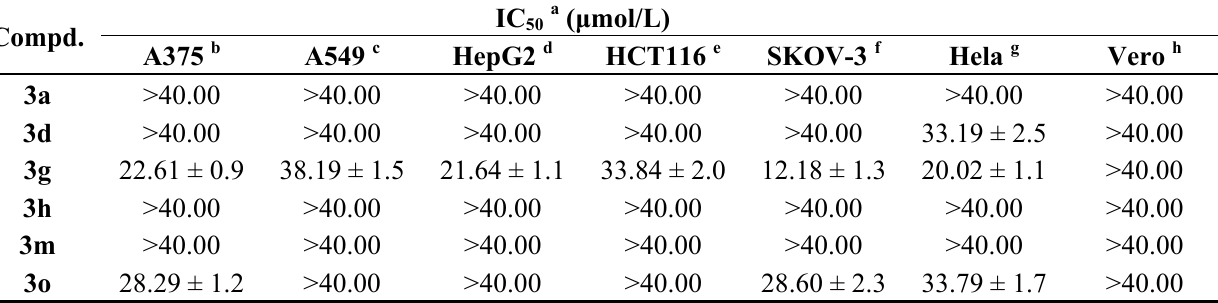
values of some 2-(3-fluoro-4-nitrophenoxy)- N -phenylacetamide derivatives Table 3. The IC 50 on six tumor cell